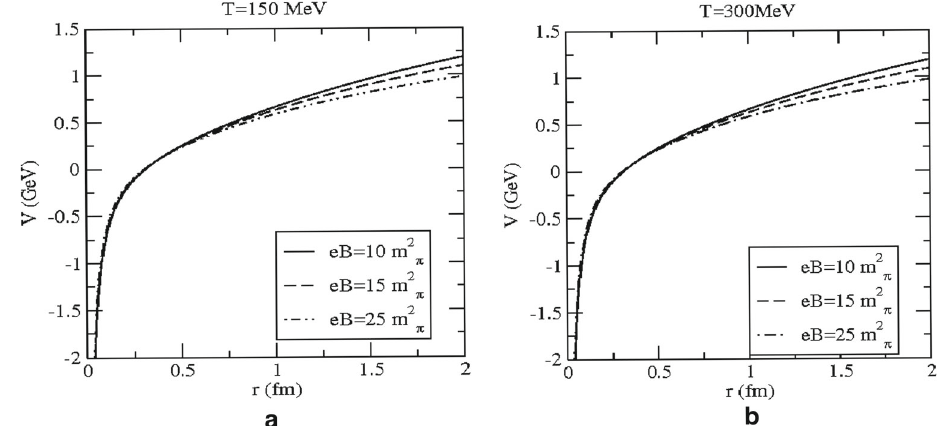
Fig. 3 Effect of the magnetic field on